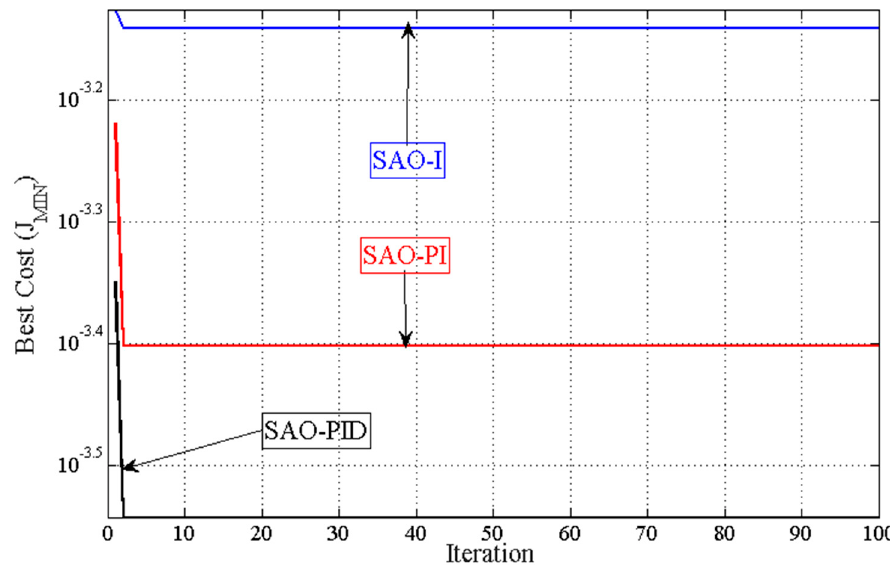
Figure 9. Convergence ( J MIN vs. iterations) curve.